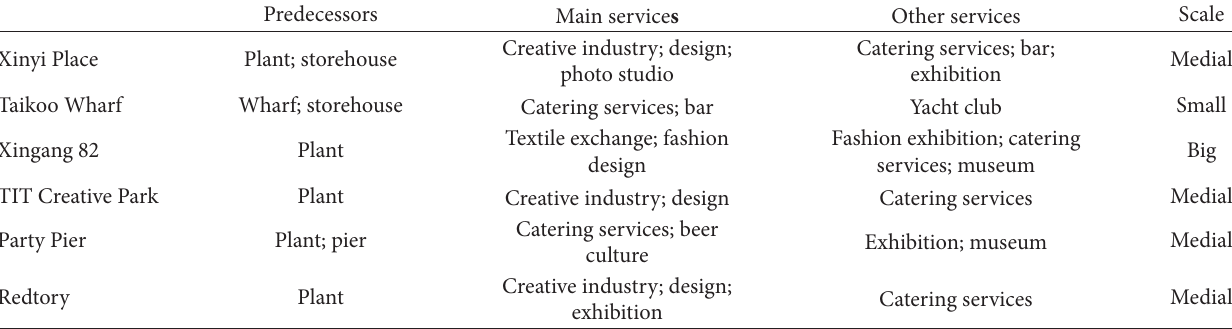
Table 1: The configuration of business in six industrial heritages.